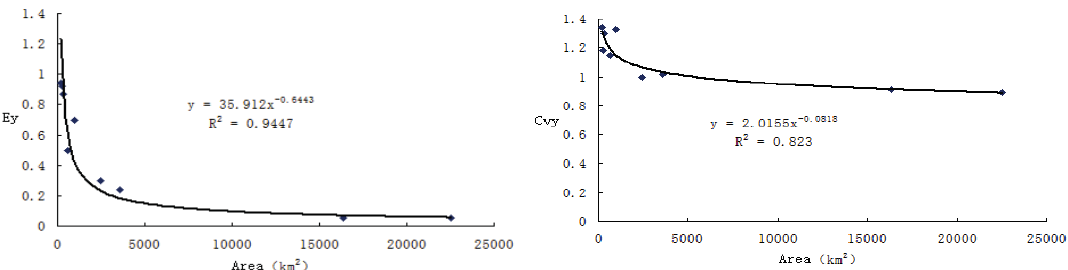
Fig. 4 Relationship between Ey and catchment area, Cvy and catchment area, in a homogenous